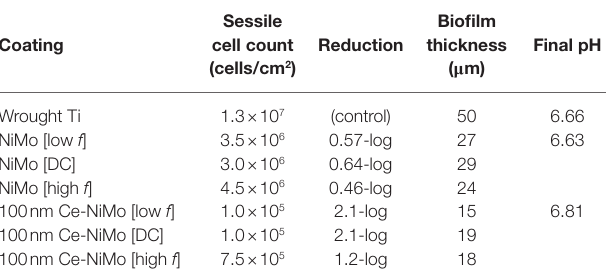
TABLE 3 | Sessile cell counts, biofilm thickness from CLSM and final pH after 21-day SRB incubation.